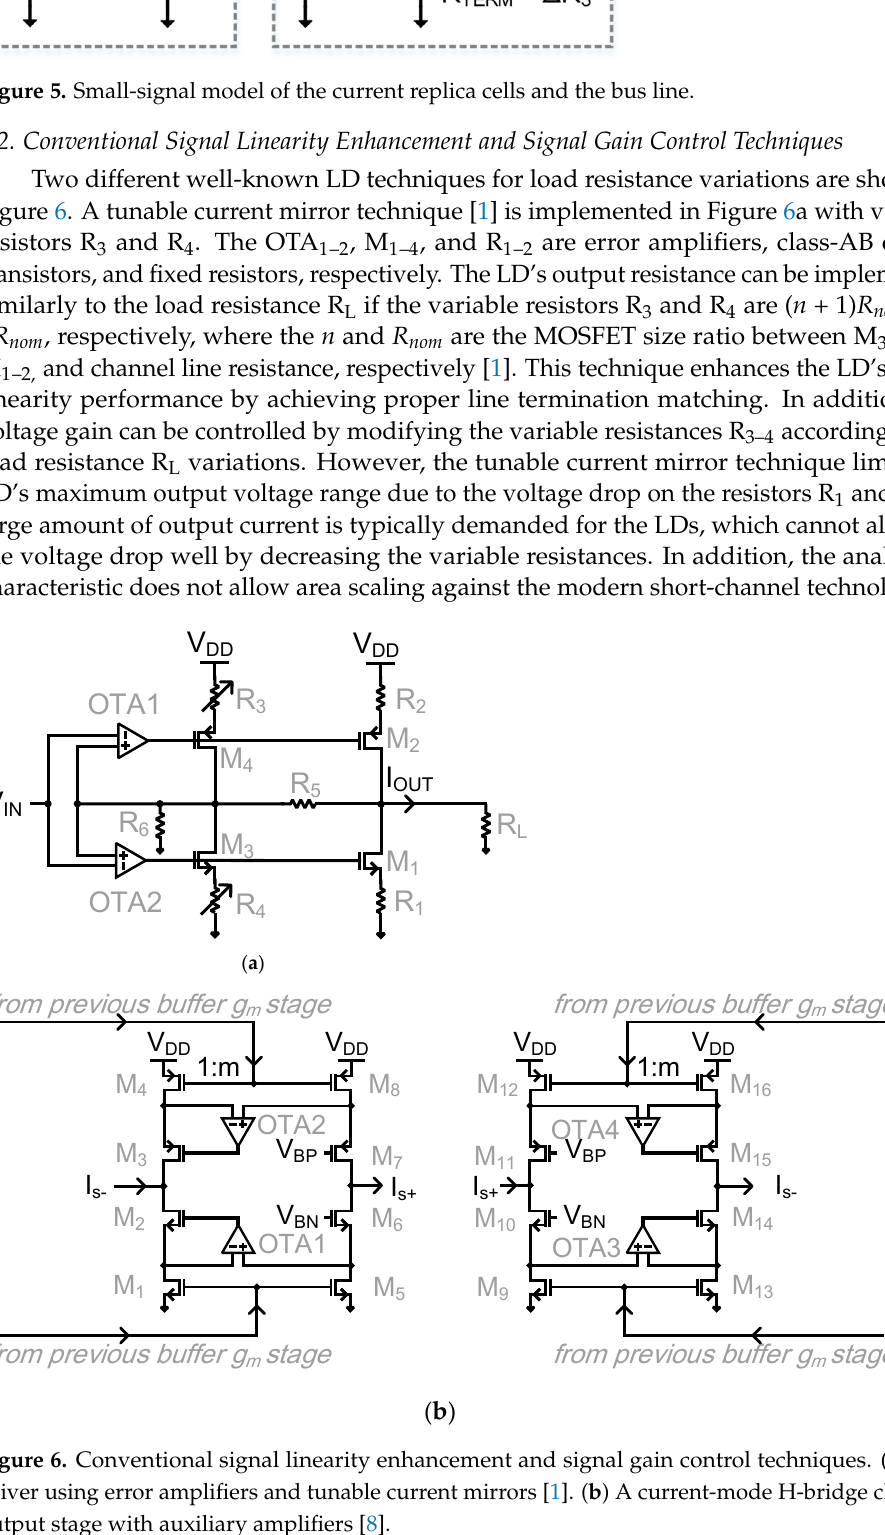
Figure 5. Small-signal model of the current replica cells and the bus line.